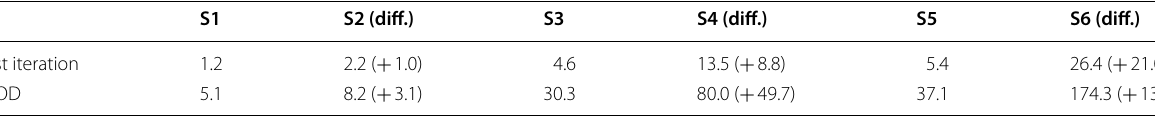
Table 5 Computing time of the first iteration and